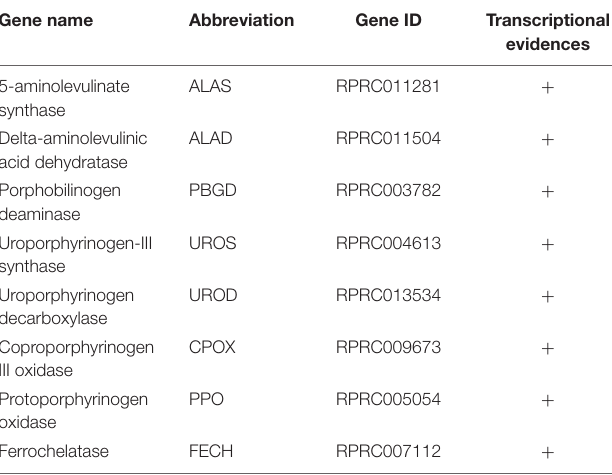
TABLE 2 | Rhodnius prolixus genes encoding heme synthesis pathway enzymes.